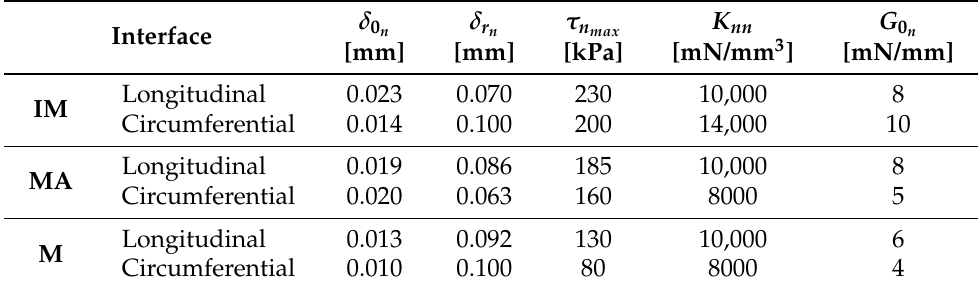
Table 3. Normal cohesive material parameters obtained by the fitting of the peel test and used to model normal failure at the